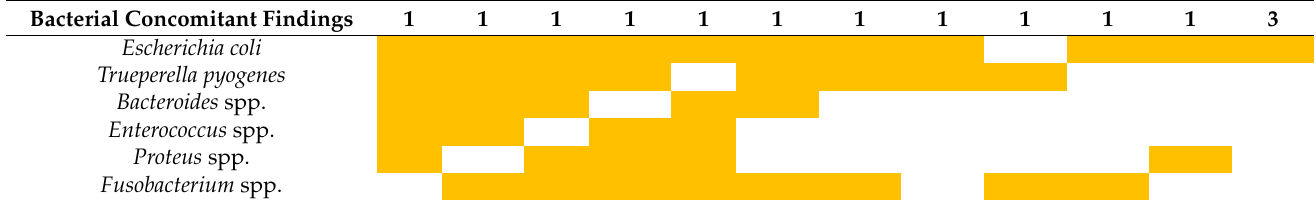
Table 7. Profiles of the accompanying findings of the C. perfringens positive cows ( n = 14) with potential uterine